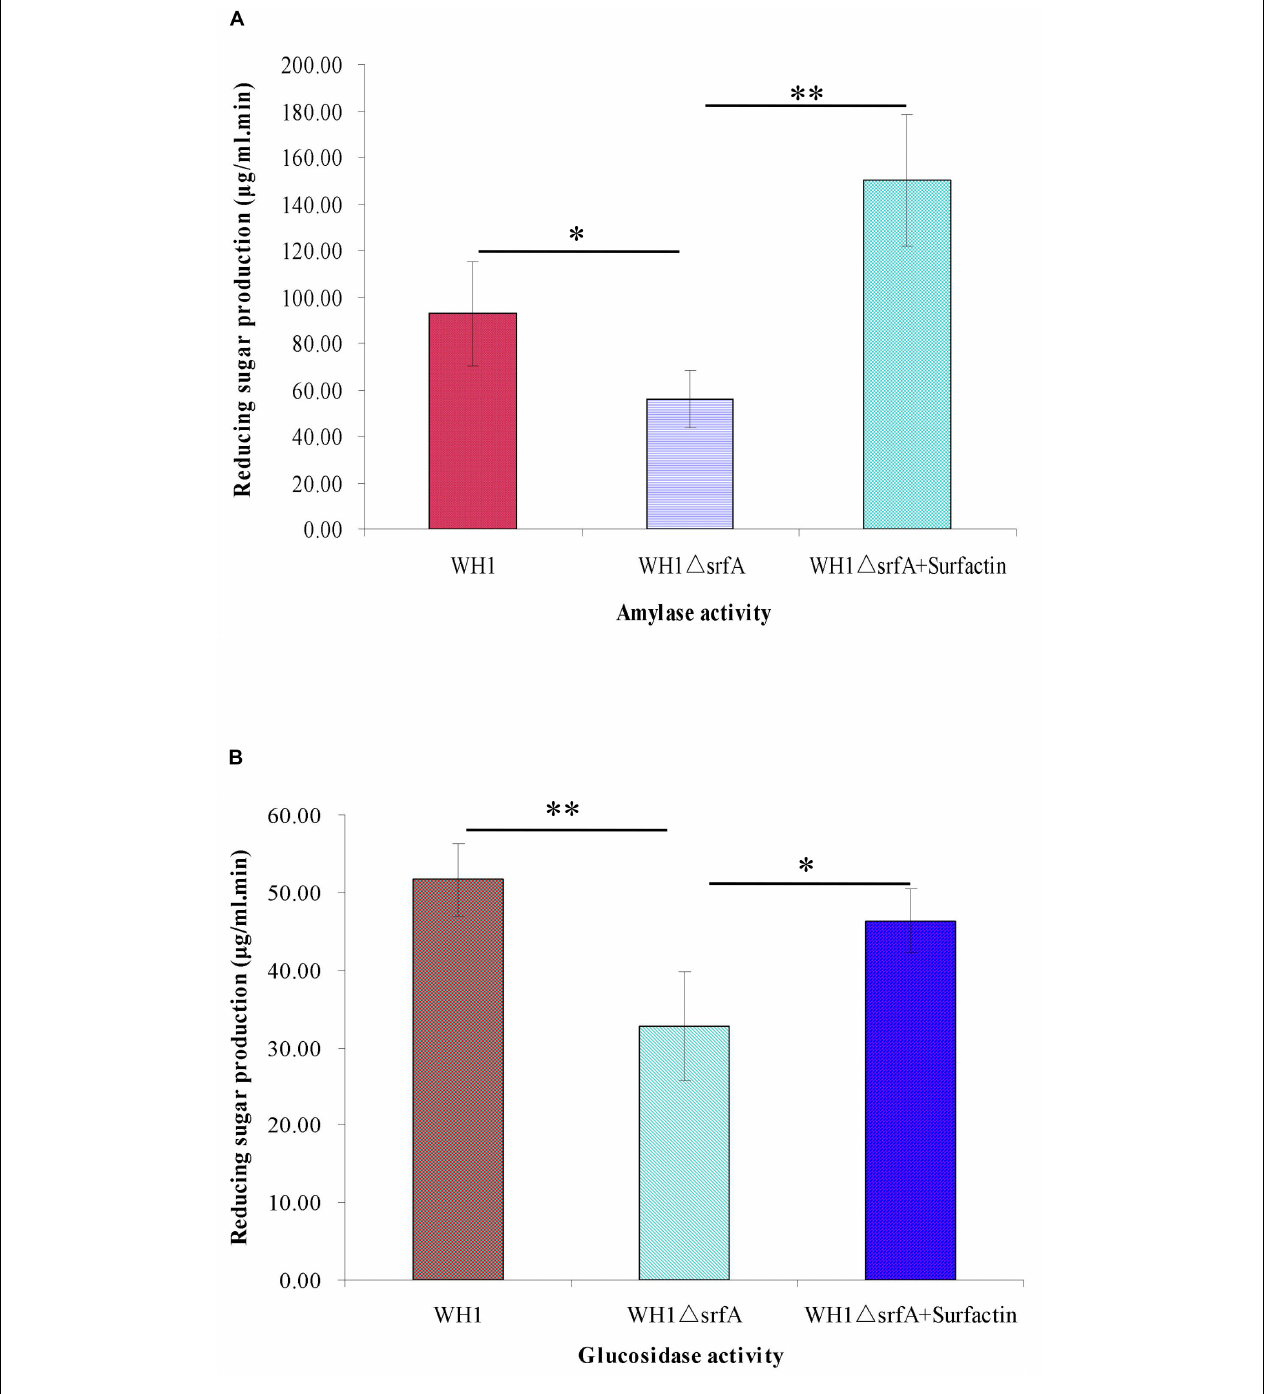
FIGURE 5 | Comparison of the activity of α -amylase and glucanase between WH1 and (cid:49) srfA . (A) Amylase activity. (B) Glucanase activity. The activity of α -amylase and glucosidase was significantly weakened in (cid:49) srfA but could be dramatically improved by addition with surfactin. Single star and double stars indicate significant ( p < 0.05) and very significant ( p < 0.01) difference between two groups, respectively.